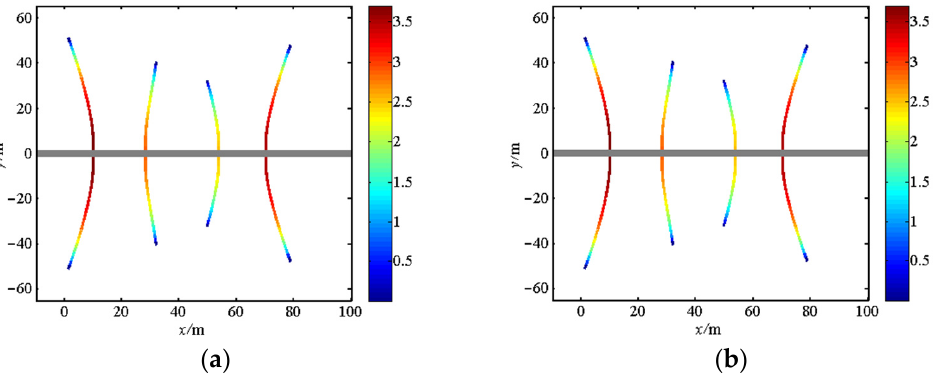
Figure 9. Fracture propagation paths and width distribution (mm) using optimized cluster spacing with different total spacings: ( a ) 60 m; ( b ) 70 m.